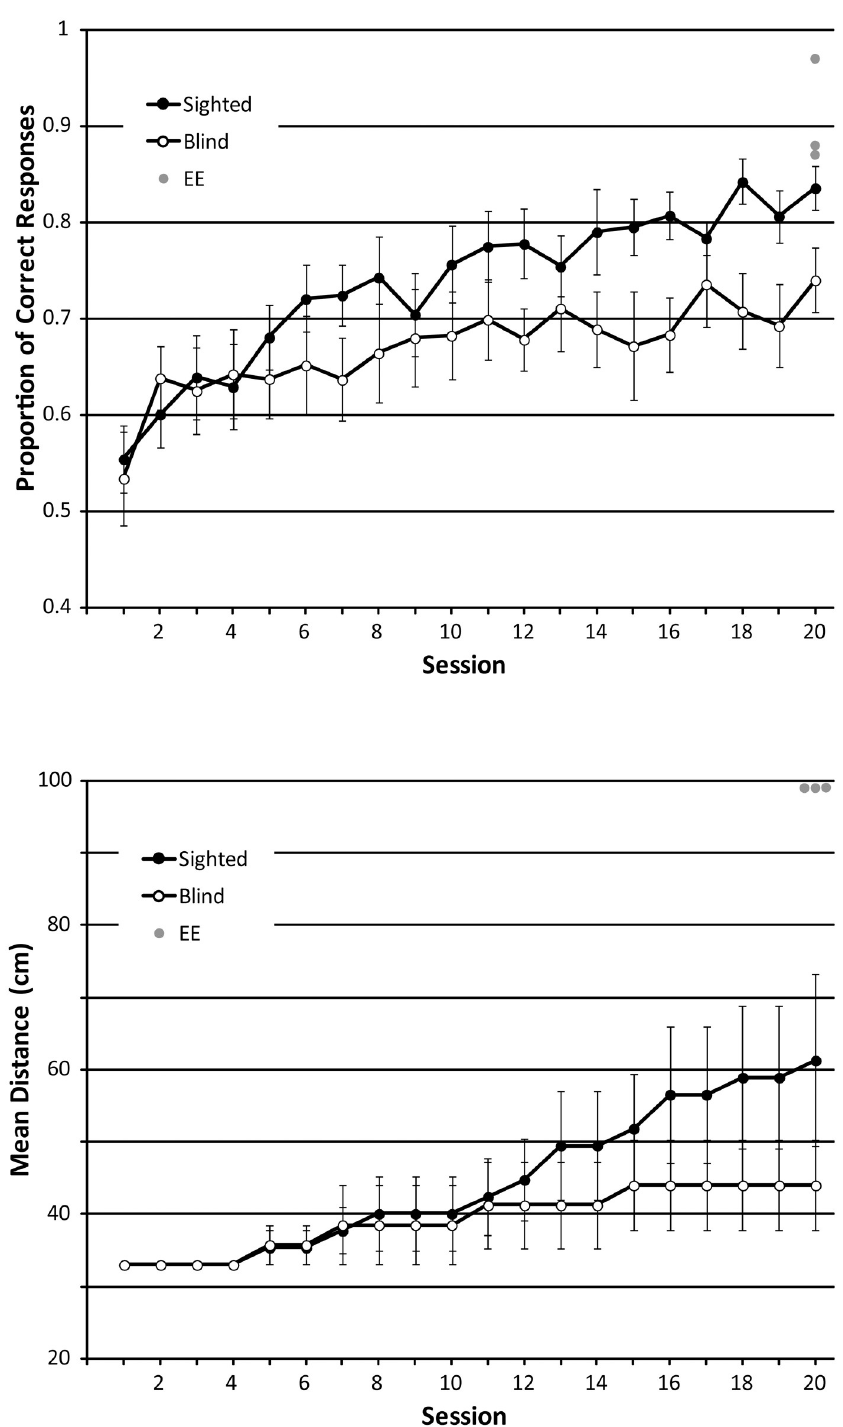
Fig 6. Performance in the size training task. Top panel: Proportion of correct answers across sessions. Chance level for proportion correct is.5. Bottom panel: Distance at which participants performed the task across sessions. Data from SCs and BCs are shown as black and white circles, respectively with each symbol representing the average and error bars representing the standard error of the mean across participants. Data from experts (n = 3) who completed only a single session without training and positioned at 100 cm distance are shown as grey circles. For comparison, they have been plotted at session 20.